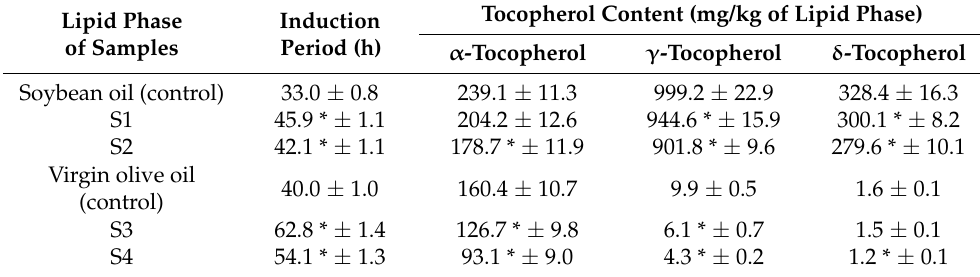
Table 3. Rancimat induction period and tocopherol content of the lipid phase extracted from tzatziki samples after 27 days of preservation at 4 ◦ C. Statistically significant differences (for p < 0.05) between sample and control are denoted with *.